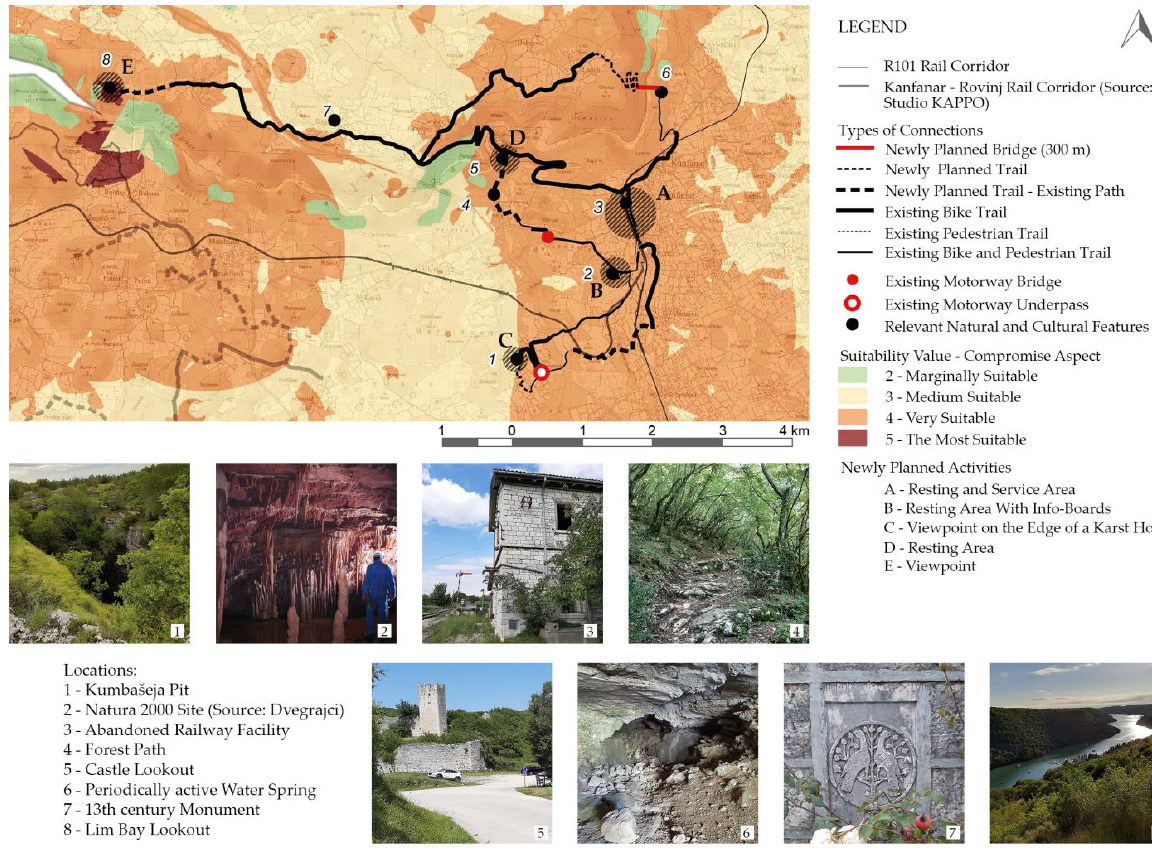
Figure 7. The Kanfanar functional area.